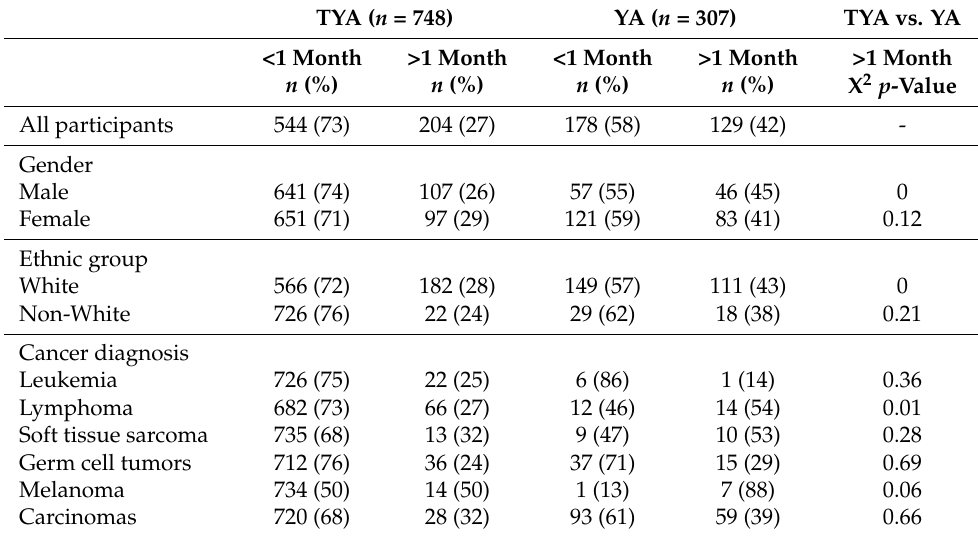
Table 5. Comparison of patient interval of TYA population with YA